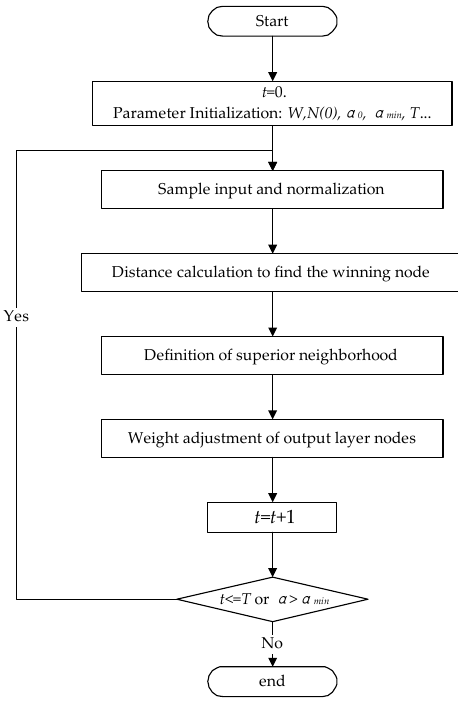
Figure 4. Procedure of battery sorting using a SOM.